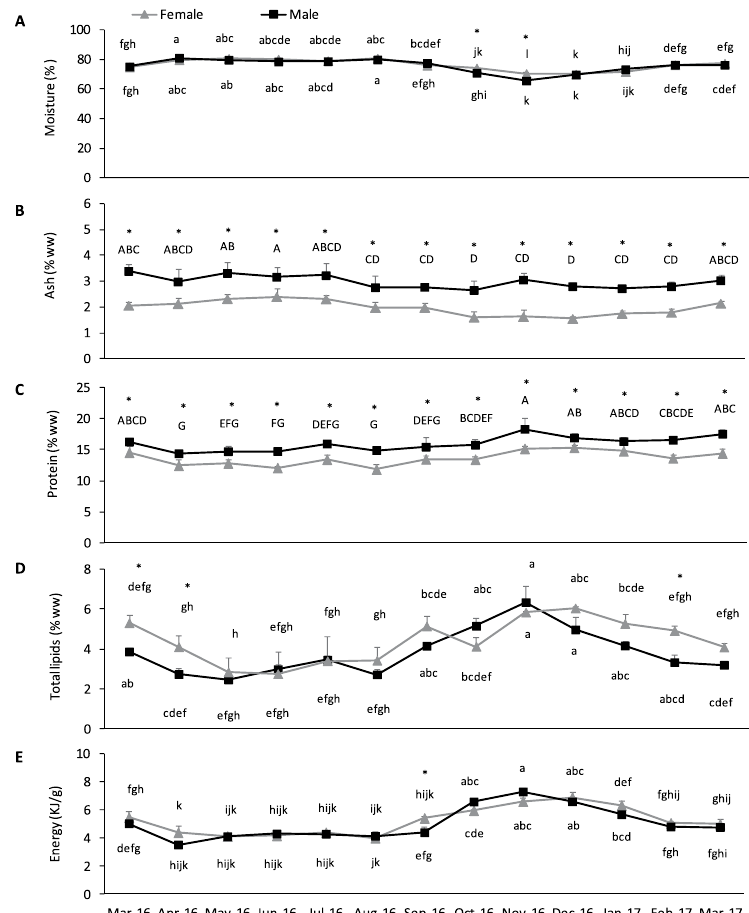
Figure 2. Changes in ( A ) moisture (%), ( B ) ash, ( C ) protein, ( D ) total lipids (% WW) and ( E ) energy (KJ/g WW) contents in gonads (ovary and testis) of P . lividus collected at Praia Norte (Portugal) over a 13-month period. Values are mean ± standard deviation; per month the 18 individuals were pooled by sex: N = 3 pools of female gonads and N = 3 pools of male gonads were established. Superscripts in capital letters ( ABC ) indicate differences between months, asterisk ( * ) indicate differences between sexes and superscripts in lowercase letters indicate significant differences between sex X month ( abc ) (P <